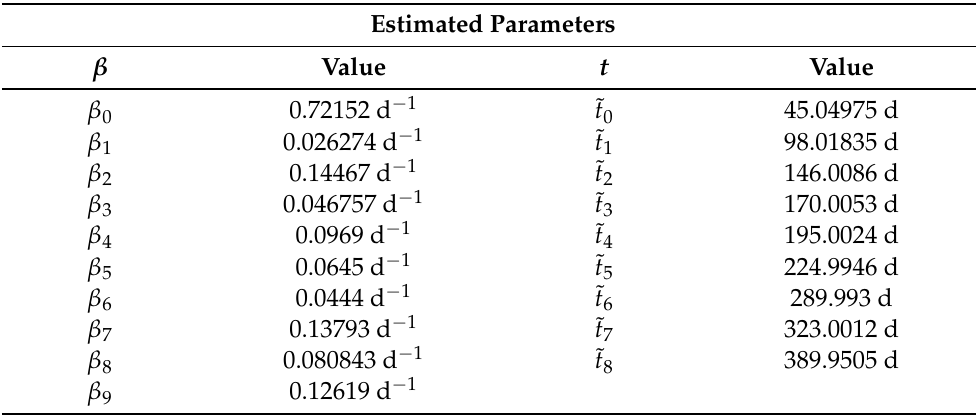
Figure 1. Comparison between SIRDV model (system (4)), with parameters of Table 2 (continuous lines) and ISR data (dashed lines). In the inset, the curve of the deaths is magnified. Table 2. Fitting parameters for the SIRDV model (4) applied to